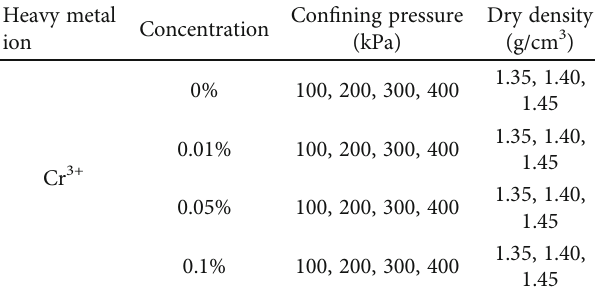
Figure 2: TKA-TTS-1 triaxial instrument. Table 2: Triaxial test